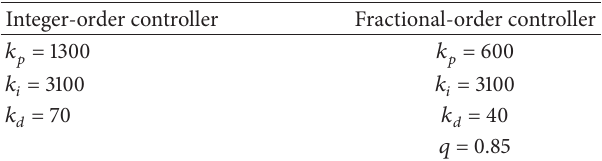
Table 3: Parameters for the